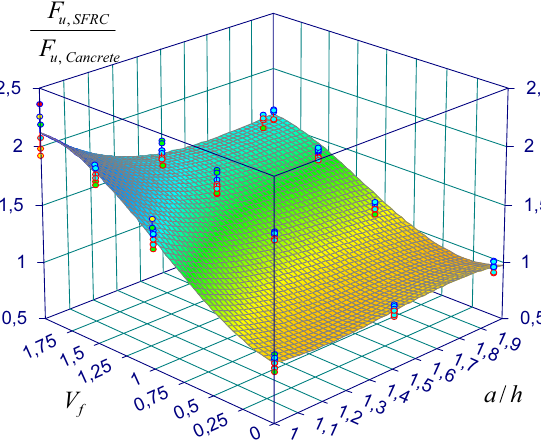
Table 2. The ratio of SFRC and concrete specimens load ca-